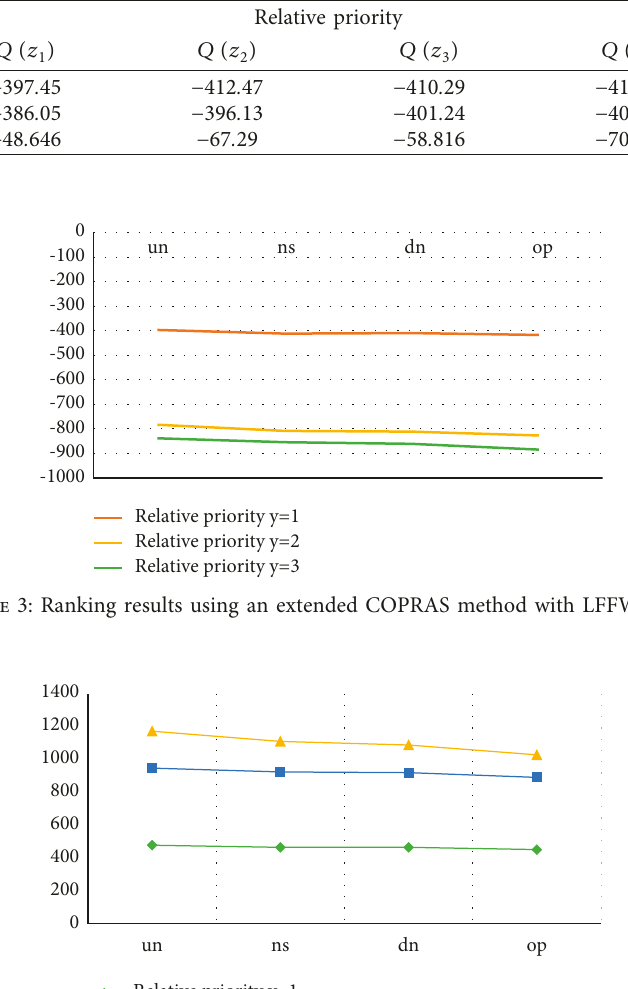
Table 19: Order for different parameters with LFFWDHM operator using the COPRAS method.